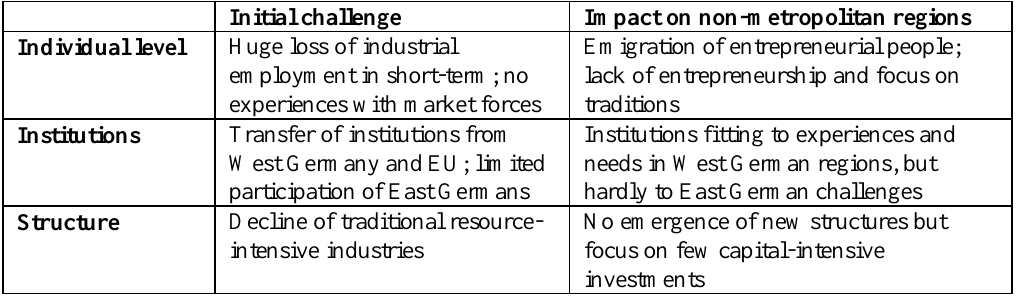
Table 1: Experiences from Economic Transition in East German Non-Metropolitan